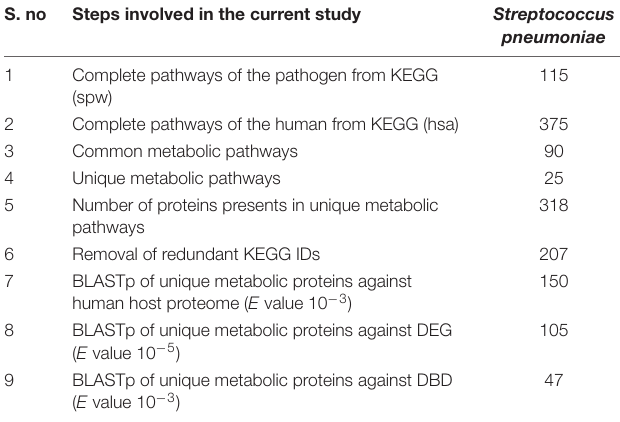
TABLE 1 | Steps involved in the current study: Subtractive filtering of proteins and metabolic pathways against S. pneumoniae .